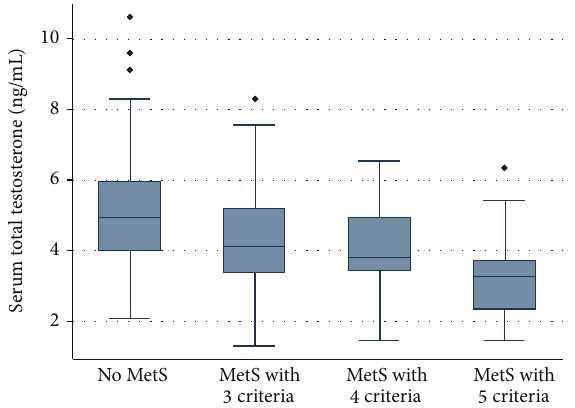
Figure 1: Box-plot representation showing a statistical significant decrease of the total testosterone levels (vertical axis) with the increase of the metabolic syndrome (MetS) parameters (horizontal axis) ( 𝑃 < 0.001 ).